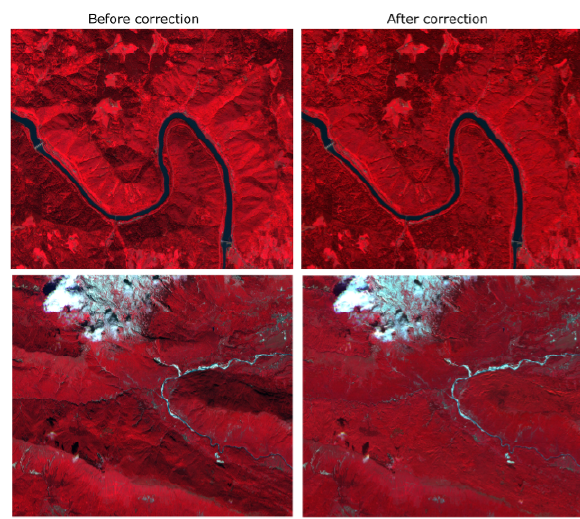
Figure 7. Close up images of correction results for